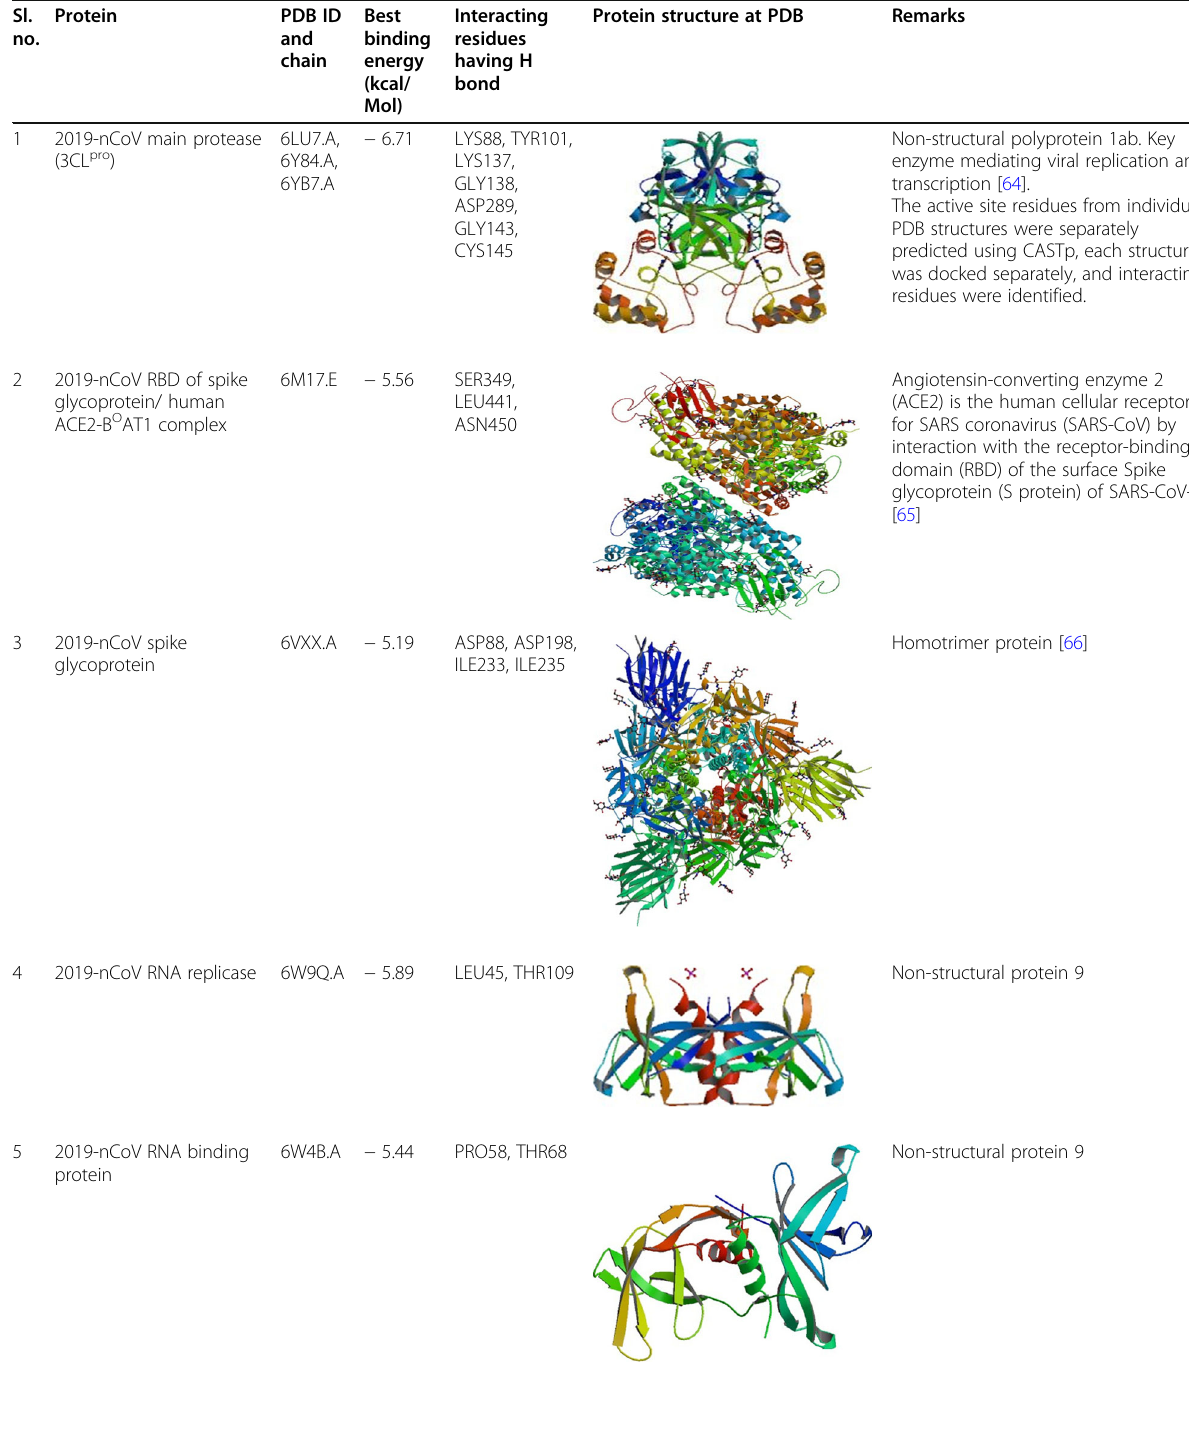
transcription [64]. The active site residues from individual PDB structures were separately predicted using CASTp, each structure was docked separately, and interacting residues were